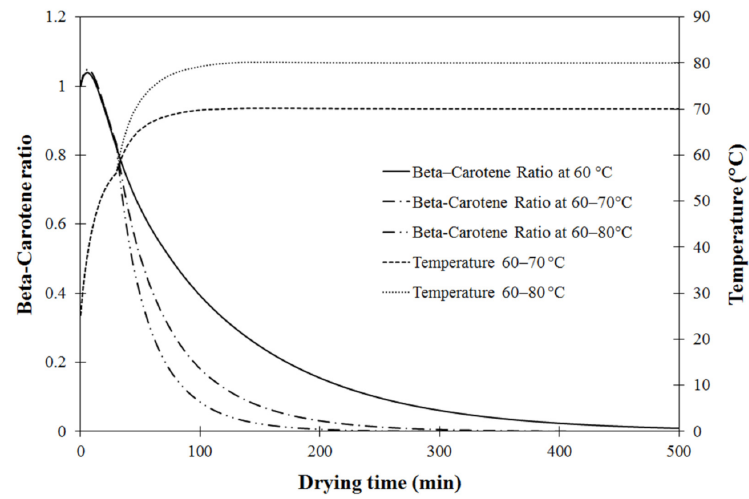
Figure 10. Comparison of simulated β -carotene ratio of carrot cubes at 60 ◦ C and two modes of step-up